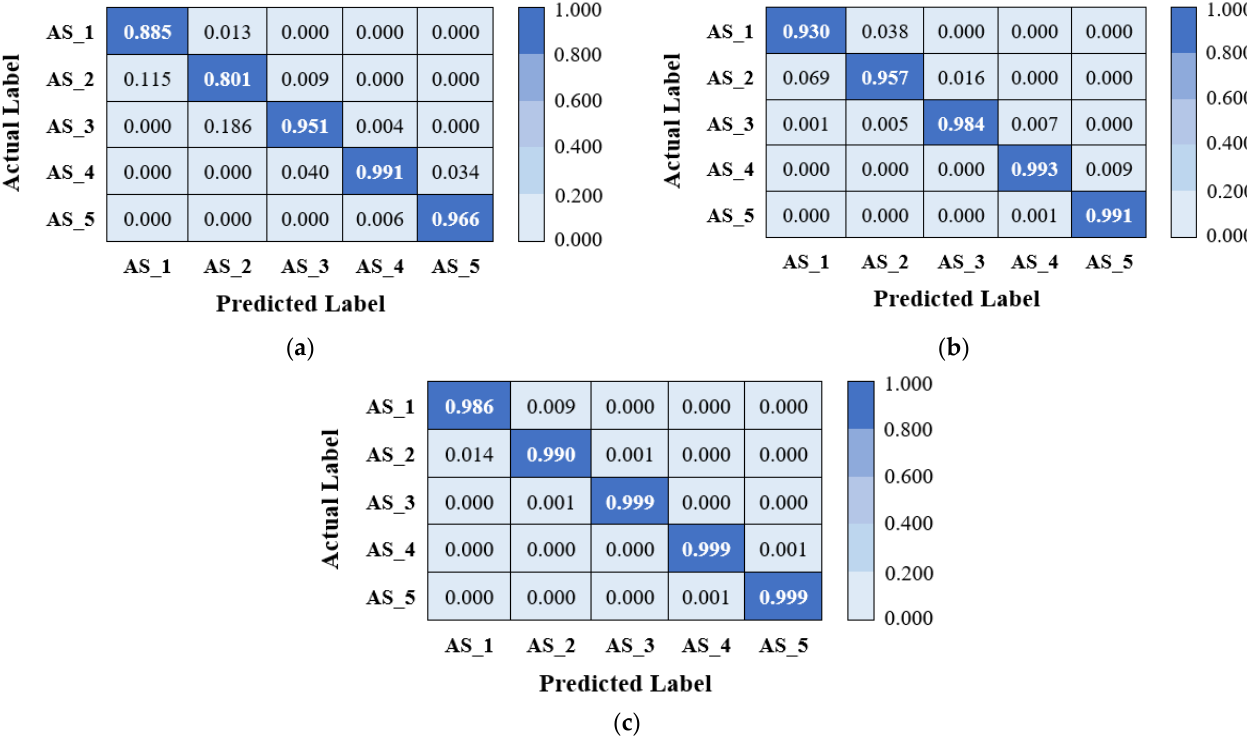
Figure 14. Confusion matrix for 20°/30° tooth pro fi le: ( a ) SNR = 5; ( b ) SNR = 10; ( c ) SNR = 15.